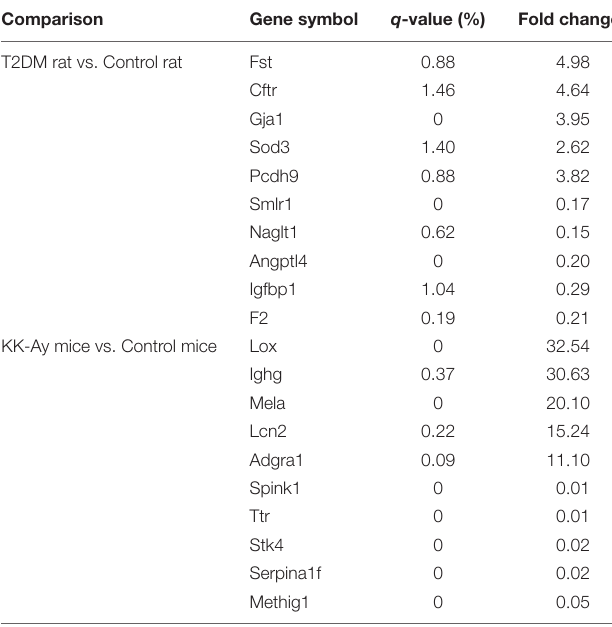
Fold Change ≥ 2 means up -regulation; Fold Change ≤ 0.5 means down-regulation.